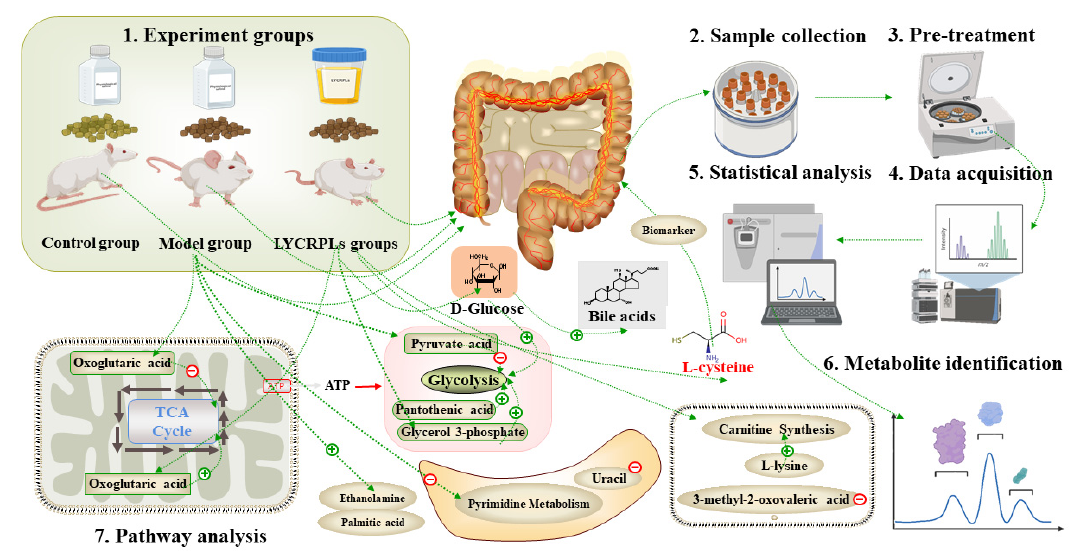
Figure 5. An analysis of the effect of LYCRPLs on SD rats fed with a high-fat diet based on GC/MS metabolomics.